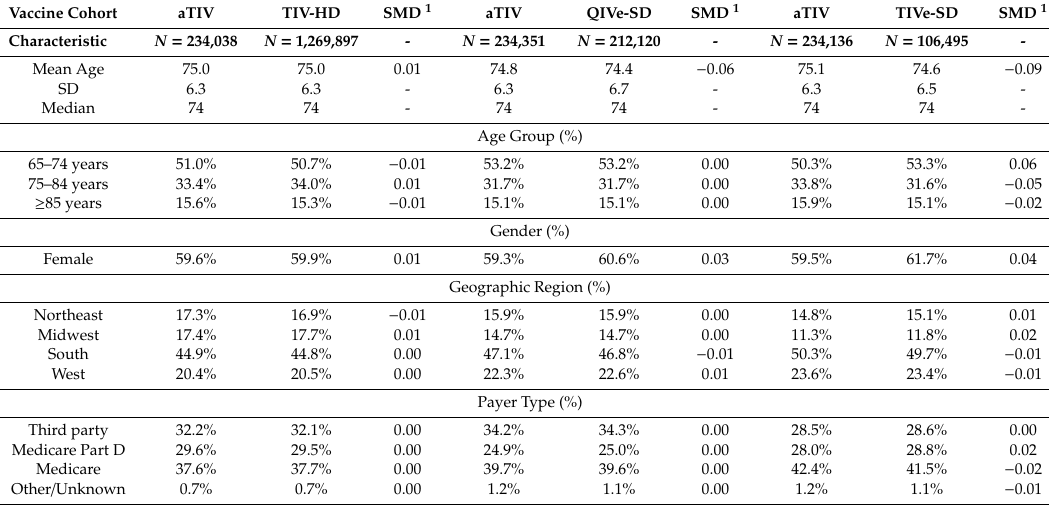
Table 1. Baseline demographic characteristics—post-inverse probability of treatment weighting (IPTW). Vaccine Cohort aTIV TIV-HD SMD 1